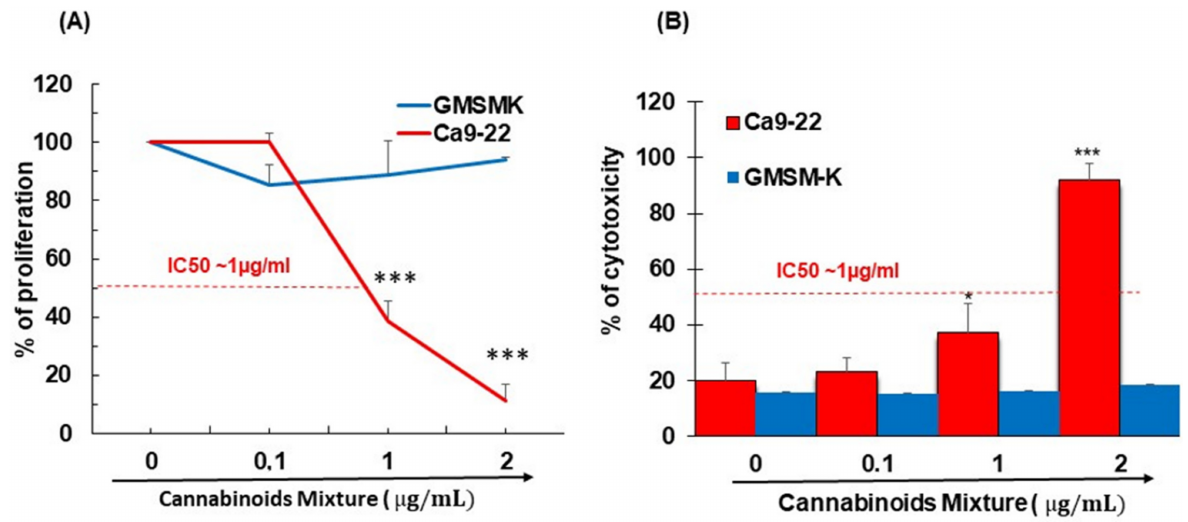
Figure 1. Proliferation of cancer cell line (Ca9-22) and non-cancerous cell line (GMSM-K) and after treatment with increasing concentrations of CM. ( A ) The cell growth was detected by the MTT assay after stimulation with various concentrations of CM for 24 h. ( B ) Cell cytotoxicity was determined after CM exposure for one day. It was measured by LDH assay. The results for each cell line were normalized to untreated controls ( n = 6 biological replicates, data are expressed as mean ± SEM). * p < 0.05, *** p <